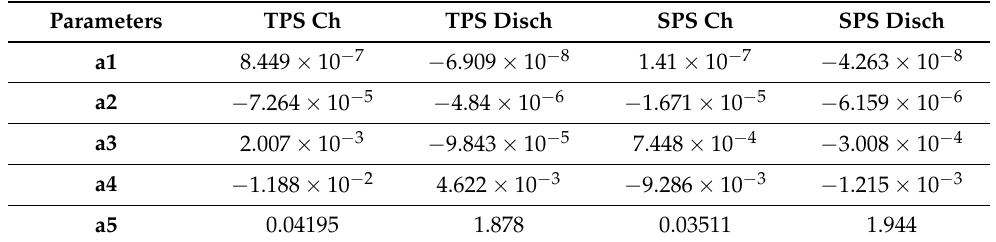
Figure 13. Phase shift with respect to current set-point using polynomial function (full lines) and standard equations (doted lines) during both charge and discharge phase. Table 5. Curve-fitting parameters for polynomial function in feed-forward